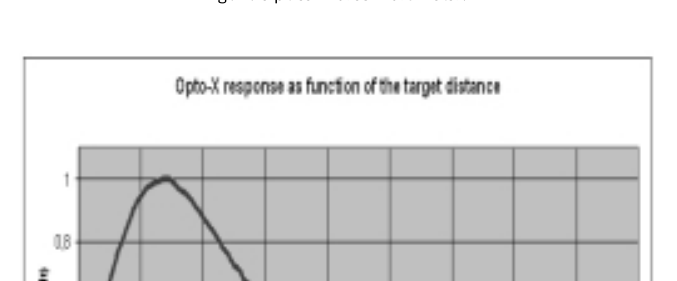
Fig. 2. Optical fibres vibrometer.